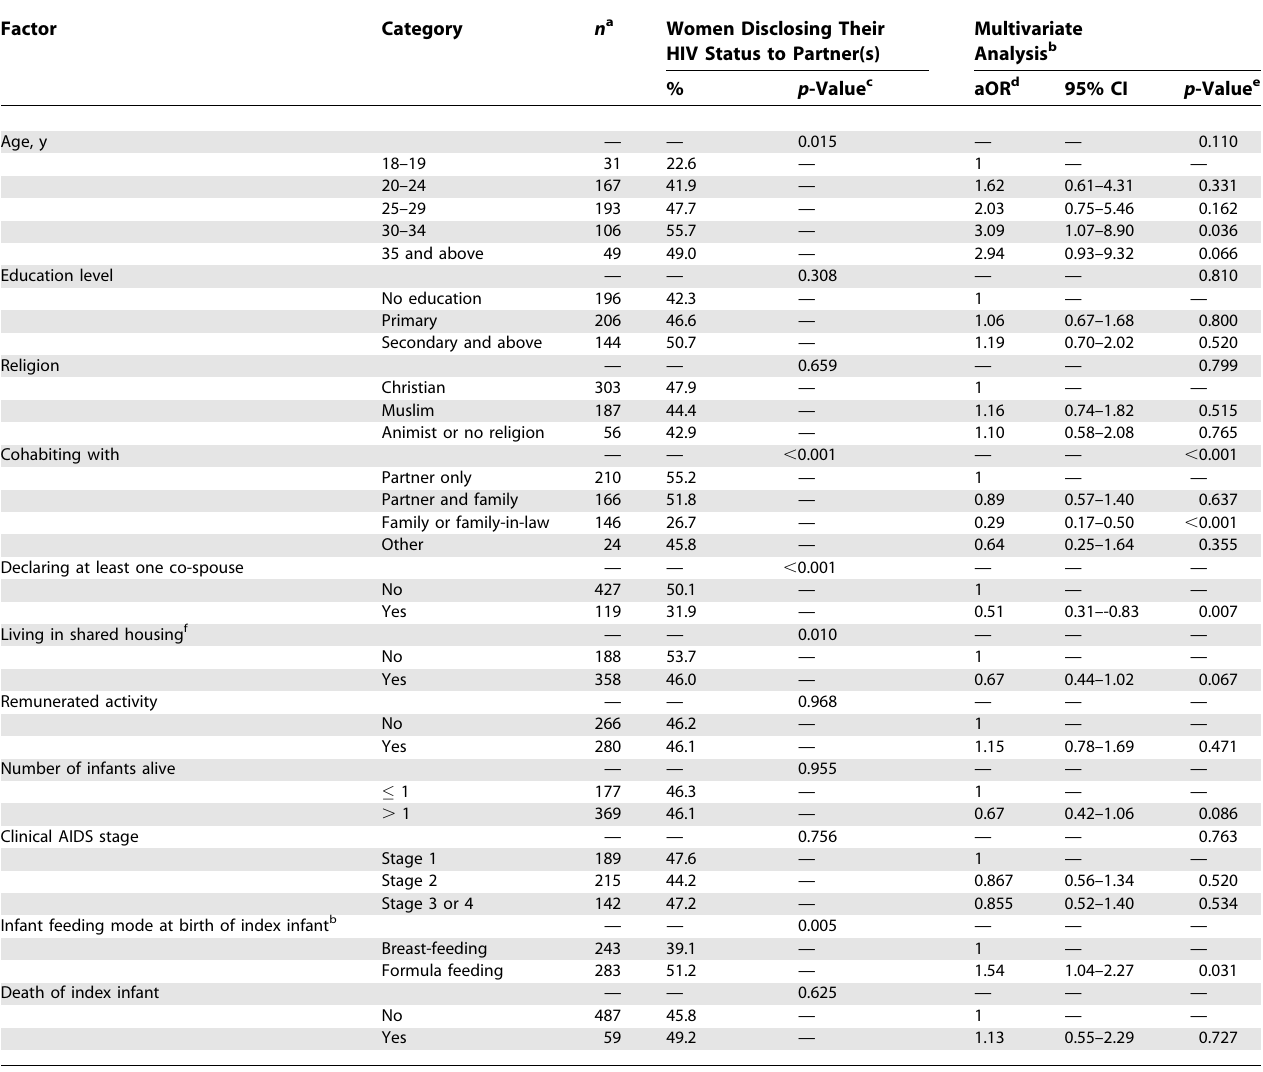
Table 2. Determinants of Women’s HIV Status Disclosure to Partners, among HIV-Infected Women: Univariate Analysis and Multivariate Logistic Regression (Ditrame Plus ANRS 1201-1202-1253, Abidjan, 2001–2005)